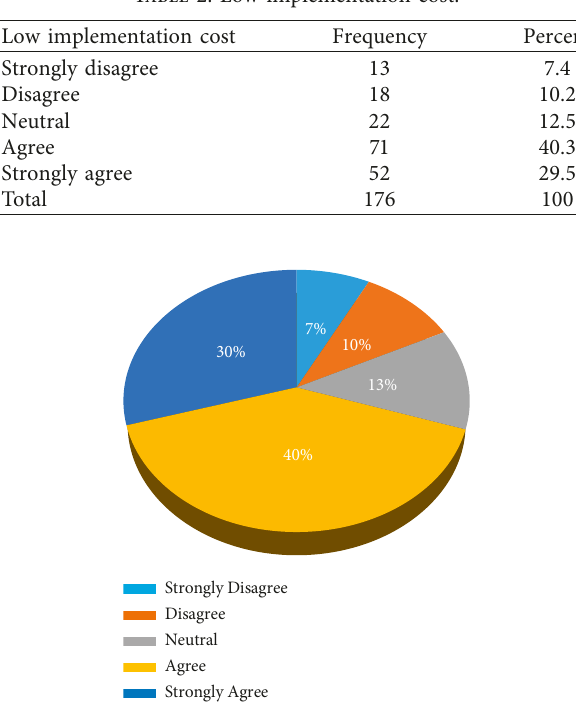
Table 3: Regression